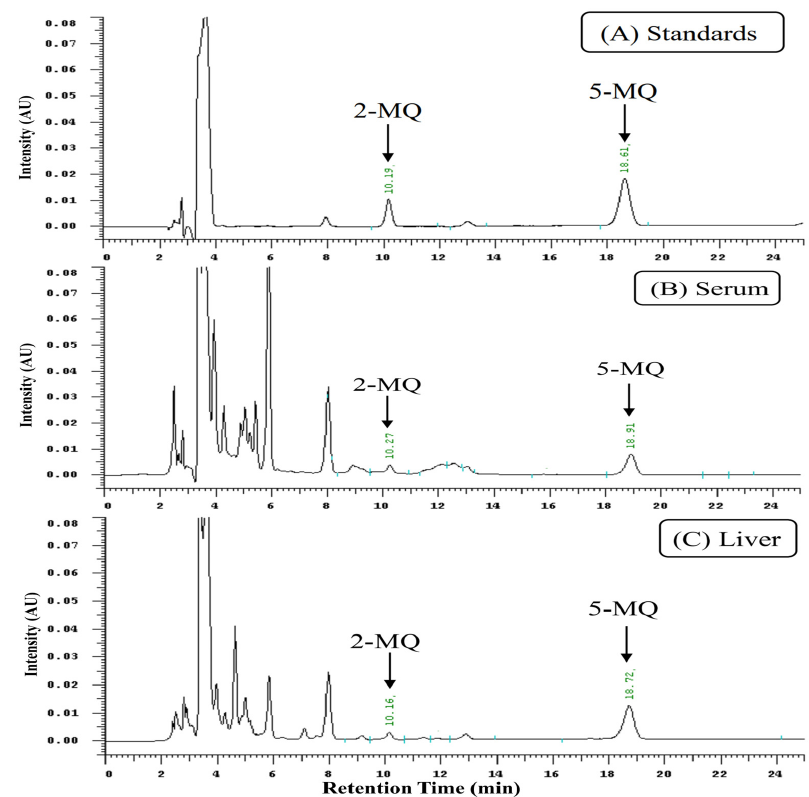
Figure 2. HPLC chromatograms obtained from detecting 2-MQ and 5-MQ. The peaks in ( A ) corre- spond to the standards, those in ( B ) are from the rats’ serum samples, and those in ( C ) are from the livers of MG-treated rats. HPLC, high-performance liquid chromatography; MQ, methylquinoxa- line.